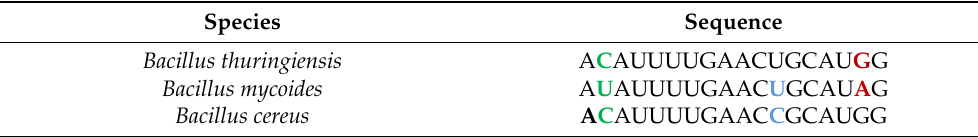
Table 1. Comparison between the 16S rRNA SNV-containing fragments of B. thuringiensis, B. mycoides , and B.